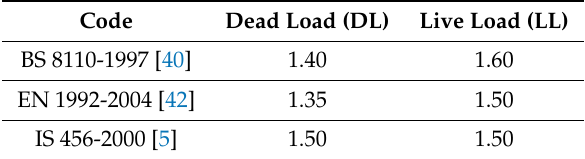
(cid:16) (cid:17) γ at the ultimate limit state (adapted from [36]). f